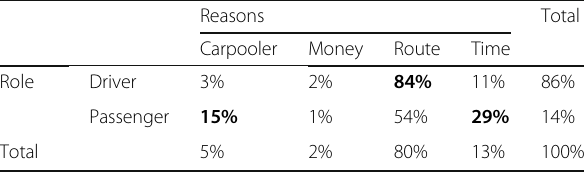
Table 4 Distribution of refusal reasons by role ( n =